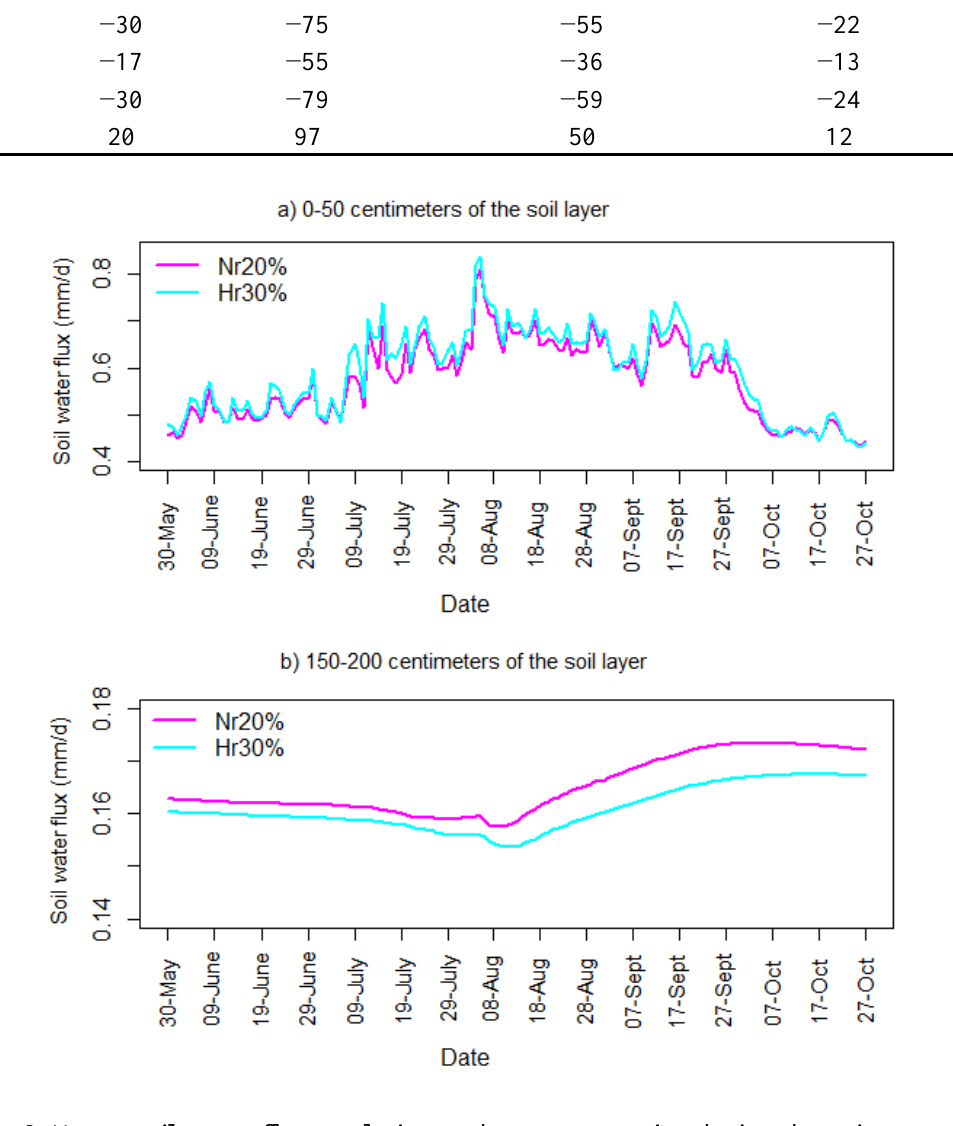
Figure 6. Mean soil water flux evolution under two scenarios during the rainy season for two soil depths. Decrease of 20% in the number of rain days designed as Nr20%; decrease of 30% in the intensity of daily rainfall designed as Hr30%. ( a ) 0–50 centimeters of the soil layer; ( b ) 150–200 centimeters of the soil